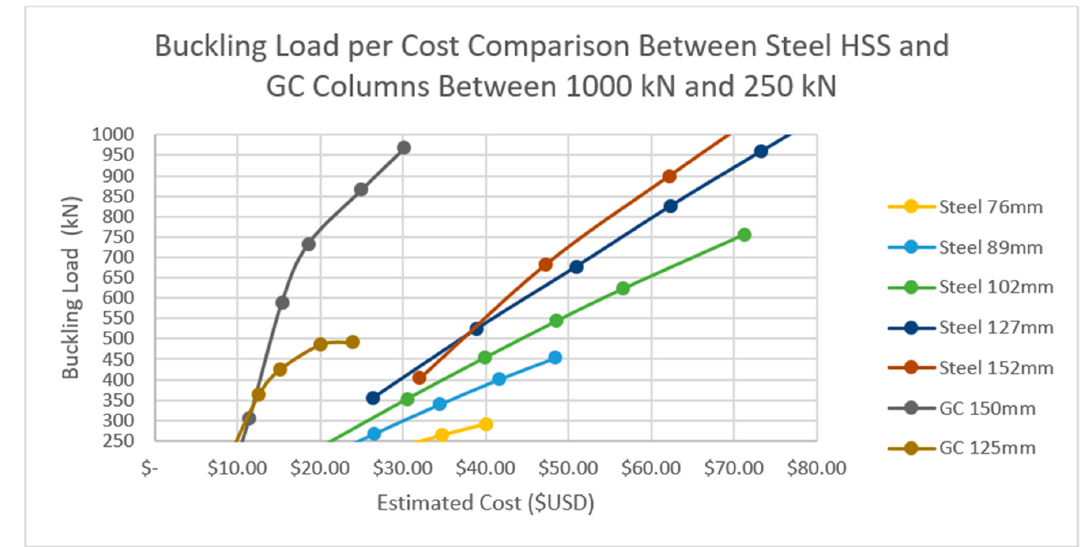
Figure 13. The cost vs. buckling load comparison between the hollow-structural-steel (HSS) sections and the GRCCs. This figure covers the buckling loads for 1000 to 250 kN.